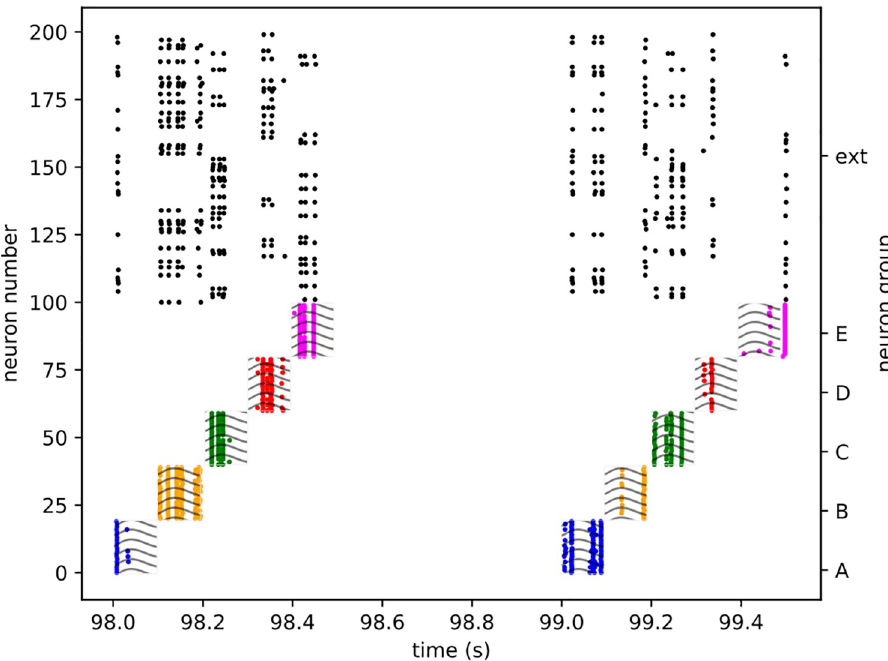
Fig 3. Training activity. A spike raster plot of a section of training activity for one of the trials. Different clusters are highlighted by different colors, and training stimulation is represented by the wavy line overlay.